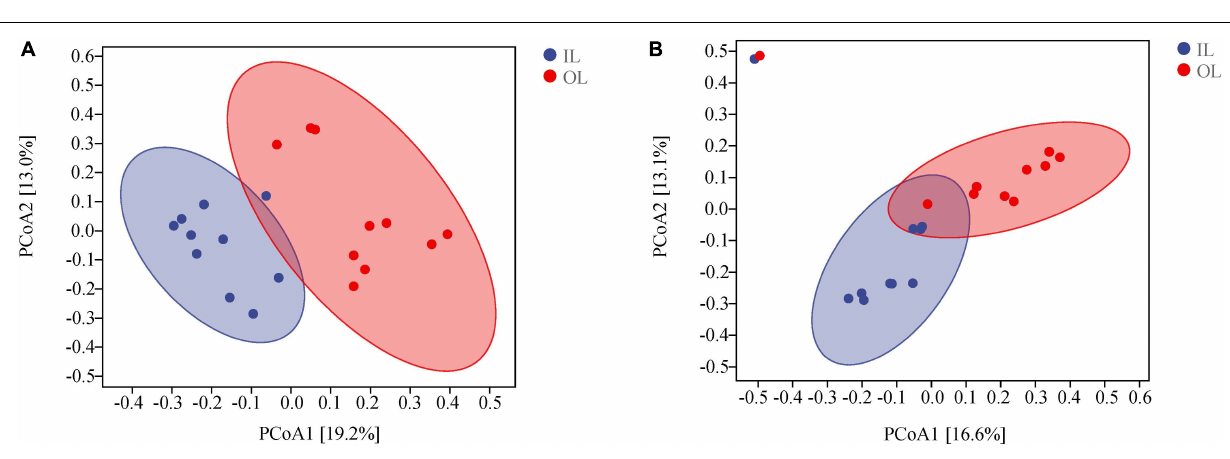
FIGURE 2 | Microbial community structures in the sediments of Qilianyu lagoon and surrounding area. Bray-curtis principal coordinate analysis of bacterial (A) and fungal (B) community